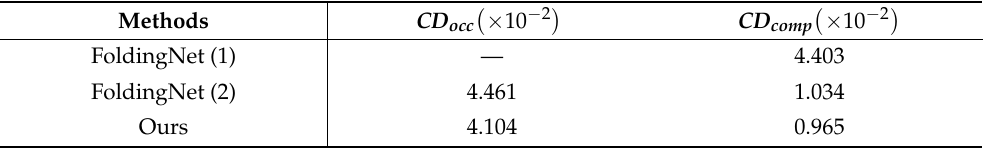
Figure 4. Output results of different methods. Occluded part represents the predicted point cloud of the occluded part, complete represents the complete point cloud after splicing with the unoccluded part. Since FoldingNet (1) was trained using the first method, which directly outputs the completion point cloud, there is no occluded part column. Table 1. Quantitative comparison of different methods.